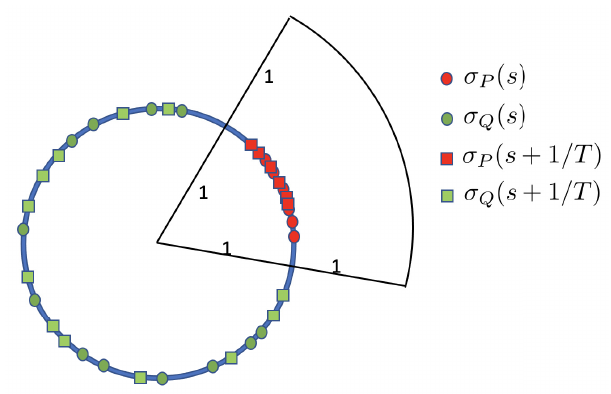
FIG. 7. An illustration of the choice of the contour (cid:11)( s , k ) for k = 1. That is, there are two successive steps of the walk and we would need to consider the spectrum for both. We need to be able to use a contour that separates out the spectrum of interest for both steps of the walk. This ensures that we have projectors onto the spectrum of interest that are consistent for both steps, with a gap between the contour and the eigenvalues. We do not allow eigenvalues of interest to cross the gap between one step and the next. Again, we show a contour with radius 2 but we would take the infinite limit of the